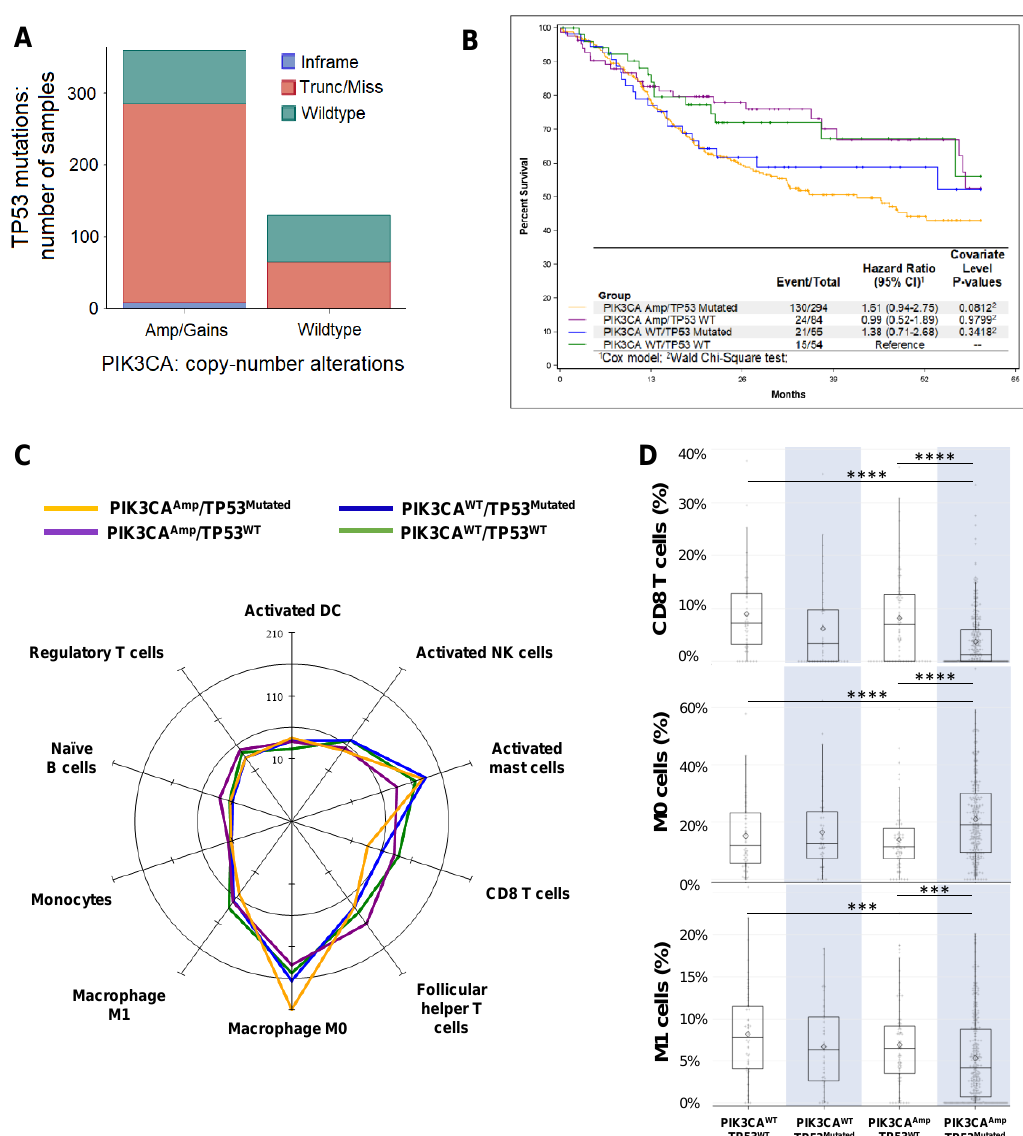
Figure 1. Analysis of The Cancer Genome Atlas (TCGA) datasets of Head and Neck Squamous cell carcinoma (HNSCC) patients. ( A ) Association between PIK3CA gene alterations and TP53 gene mutation in HNSCC patients (TCGA, PanCancer Atlas, n = 489 samples). The Cancer Genome Atlas (TCGA) RNA-seq data and clinical data of HNSCC cohorts were obtained from the cBioPortal (https: // cbioportal.org) (see details in Method). Patients with PIK3CA Amp / gain ( n = 359) had a higher chance to harbor TP53 mutations than patients with PIK3CA WT ( n = 130). ( B ) Kaplan-Meier overall 5-year survival curves of HNSCC patients in 4 groups (PIK3CA Amp / TP53 Mutated , PIK3CA Amp / TP53 WT , PIK3CA WT / TP53 Mutated , and PIK3CA WT / TP53 WT ) as described in Methods. Only patients with available survival data were included for this analysis ( n = 487). ( C ) A radar plot of the cell types that reached significance in the omnibus Kruskal-Wallis test when comparing among the 4 groups. The scale is per 1000 cells. ( D ) Box and whisker plots of CD8 T cells, resting macrophages (M0), and M1 macrophages. The expression of CD8 T cell signature genes: PIK3CA Amp / TP53 Mutated group (3.77 ± 5.32) was significantly lower ( p < 0.0001) than groups of PIK3CA WT / TP53 WT (8.97 ± 7.86) and PIK3CA Amp / TP53 WT (8.22 ± 8.12). The expression of M0 signature genes: PIK3CA Amp / TP53 Mutated group (21.07 ± 14.08) was significantly higher ( p < 0.0001) than groups of PIK3CA WT / TP53 WT (15.25 ± 12.32) and PIK3CA Amp / TP53 WT (13.93 ± 11.23). The expression of M1 signature genes: PIK3CA Amp / TP53 Mutated group (5.35 ± 5.05) was significantly lower ( p < 0.0002) than groups of PIK3CA WT / TP53 WT (8.17 ± 5.62) and PIK3CA Amp / TP53 WT (6.92 ± 5.17).